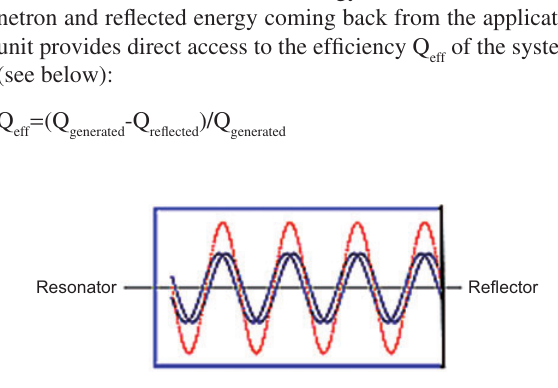
Figure 2 Creation of a standing wave in a monomode resonator.